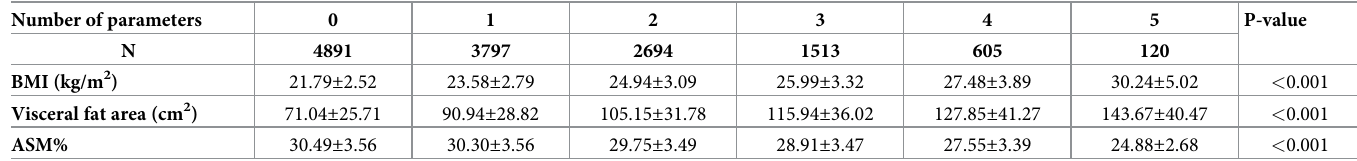
BMI, body mass index; ASM%, appendicular skeletal muscle percentage. P-value estimated from analysis of variance with linear contrast.